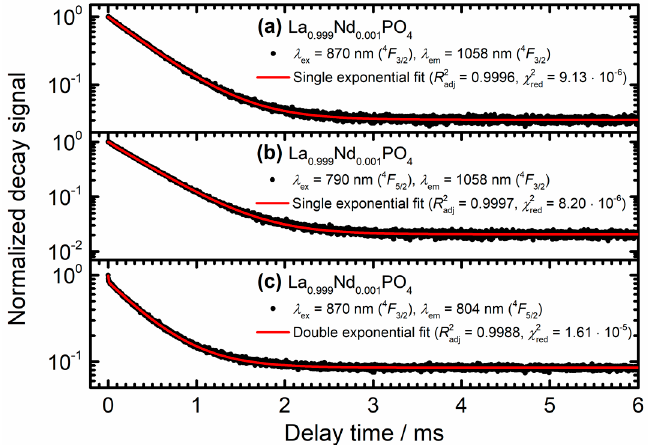
Figure 6. Luminescence decay curves of the Nd 3 + -related luminescence in microcrystalline La 0.999 Nd 0.001 PO 4 powder. The respective excitation and emission wavelengths are given. Solid red lines depict least-squares fitting curves. The relevant statistical parameters indicating the quality of the fits are also indicated. This observation indicates that the sum of radiative and non-radiative decay rate from the 4 F 5/2 em (cid:4666) T (cid:4667) , have to be much higher than the radiative decay rate k level, k r ( 4 F 5/2 ) + k nr